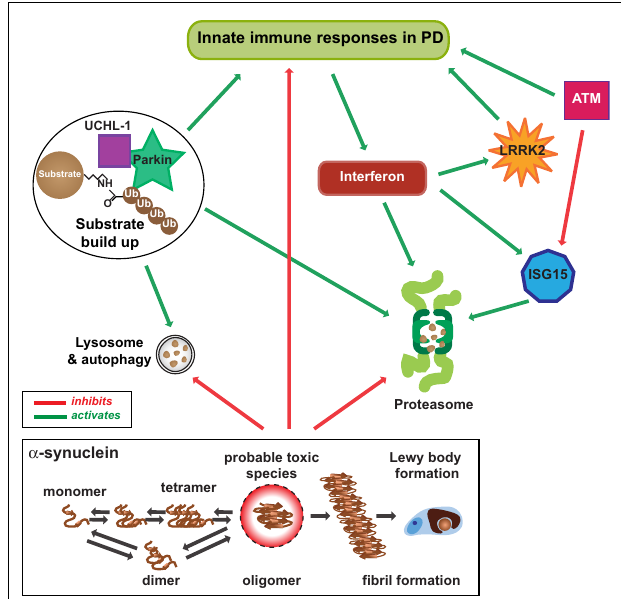
FIGURE 2 | Innate immunity and the ubiquitin–proteasome system in PD. Innate immunity is used by the cell to increase proteasome degradation of unwanted proteins by direct and indirect stimulation of the protesome through interferon- γ and ISG15, a ubiquitin-like protein that can be attached to both host and viral proteins. ATM (and appropriately functioning LRRK2) usually stimulates innate immune signaling when necessary. However, ATM also regulates proteasome-mediated protein turnover through suppression of the ISG15 pathway, and together with dysfunctional LRRK2 could decrease proteasome activity necessary for an adequate immune response and the degradation of normal cellular protein substrates, like dimer or tetramer forms of α -synuclein. As these forms are normally degraded through the ubiquitin/proteasome and lysosome/autophagy pathways, along with other cellular substrates, dysfunction in these pathways would increase α -synuclein to form toxic oligomeric species that also inhibit the proteasome and autophagy pathways, as well as innate immunity.This scenario would lead to the increase in toxic oligomers of α -synuclein that aggregate into fibrils to form Lewy bodies over